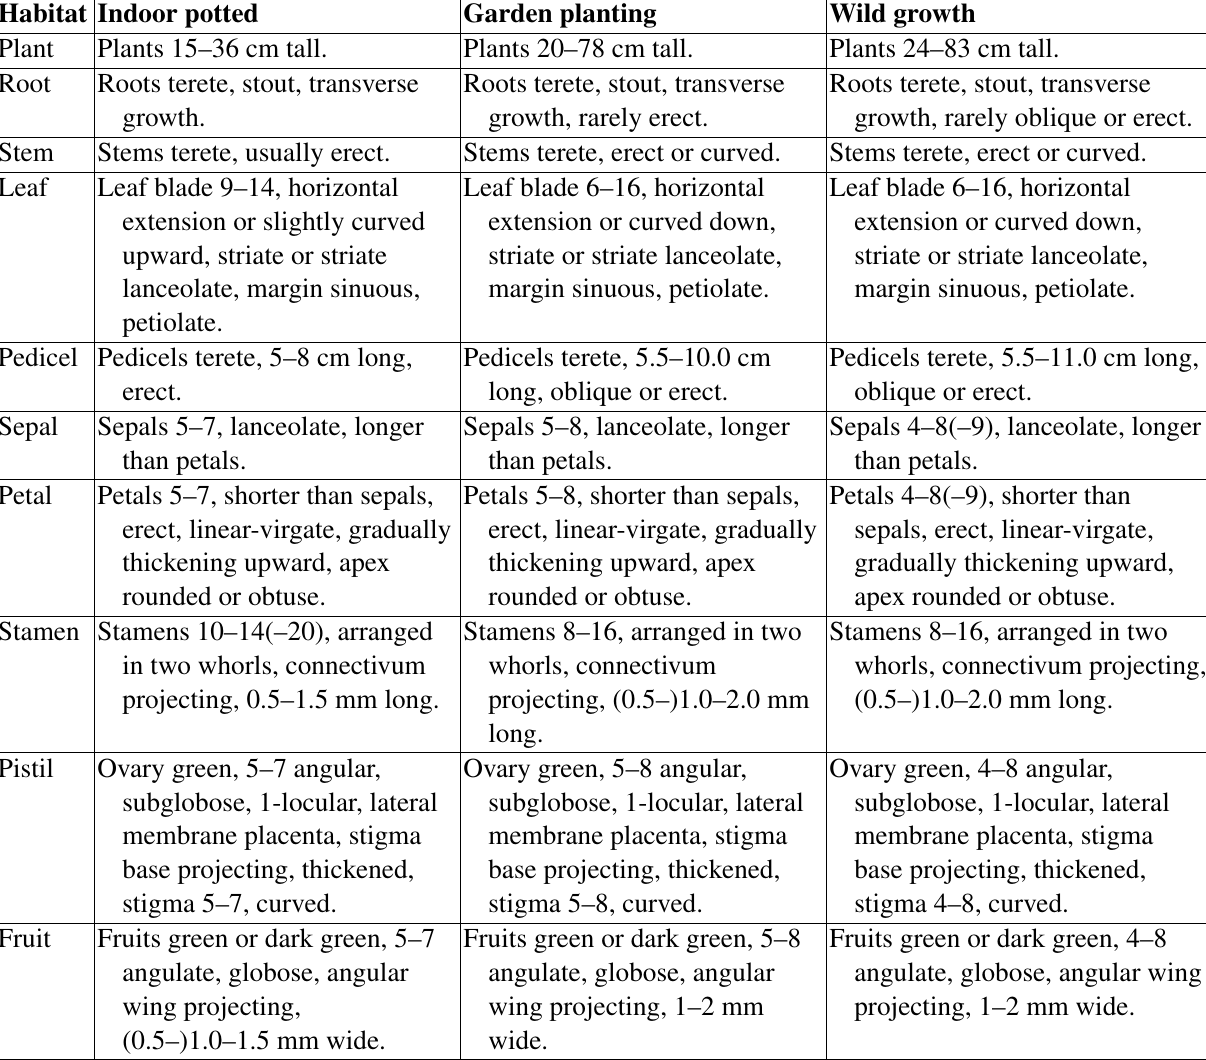
Table 1 Comparison of main morphological characteristics of Paris panxiensis (J. L. Liu) Y. Yuan & J. L. Liu in three